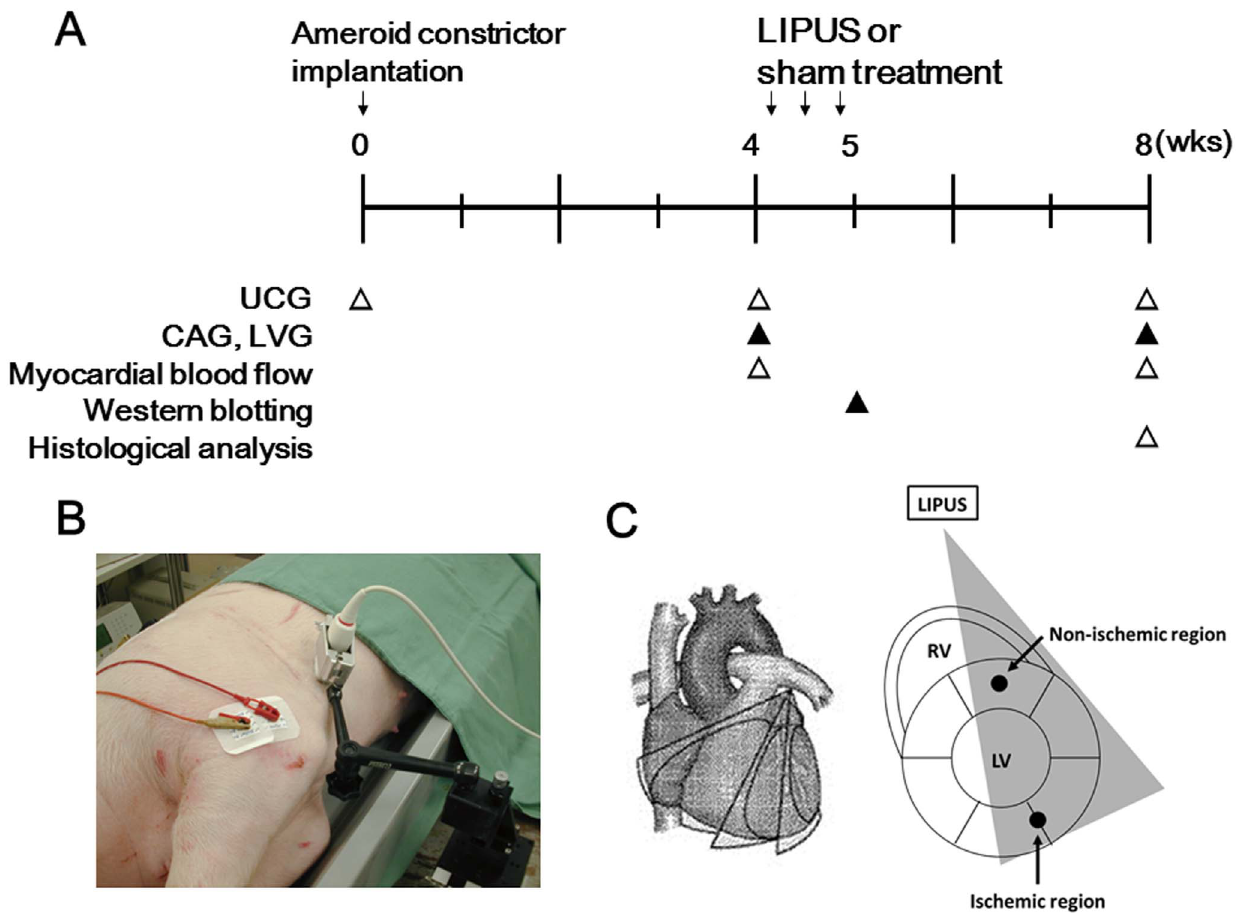
Figure 2. Experimental protocol. ( A ) Protocol, ( B ) LIPUS therapy in action, and ( C ) schematic images of LIPUS application. UCG, ultrasound cardiography; CAG, coronary angiography; LVG, left ventriculography.